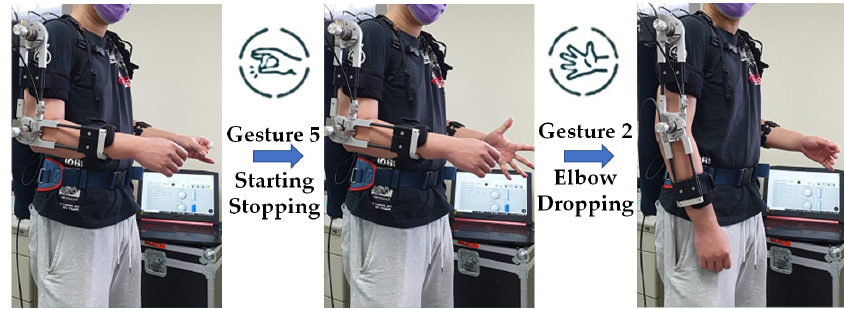
Figure 30. Basic action experiment for shoulder dropping.